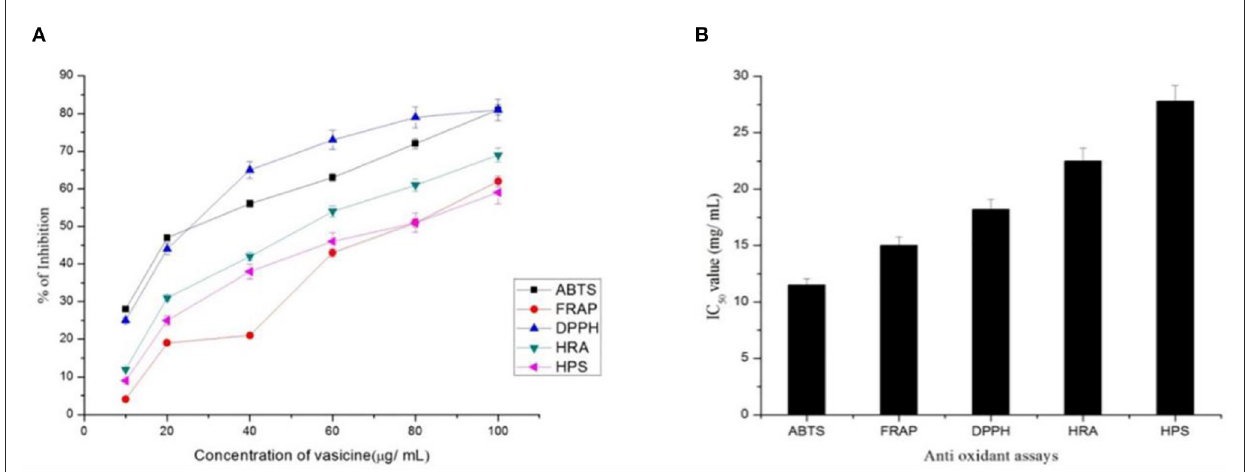
FIGURE4 (A) Percentage inhibition and (B) IC 50 value of vasicine in the antioxidant assay. ABTS, 2, 2’-azino-bis (3-ethylbenzthiazoline-6-sulphonic acid) scavenging Activity; FRAP, Ferric Reducing Antioxidant Power Assay; DPPH, 1,1 Diphenyl-2-picrylhydrazyl Radical Scavenging Activity; HRA, Hydroxyl Radical Scavenging Assay; HPA, Hydrogen Peroxide Assay.